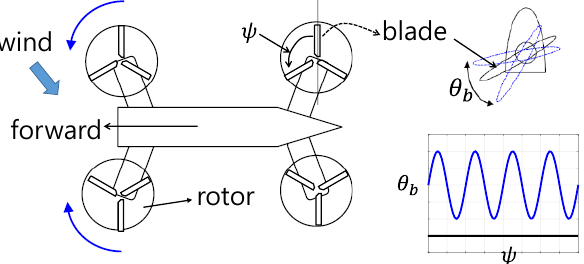
Figure 2. UAM, its rotors, and blade pitch